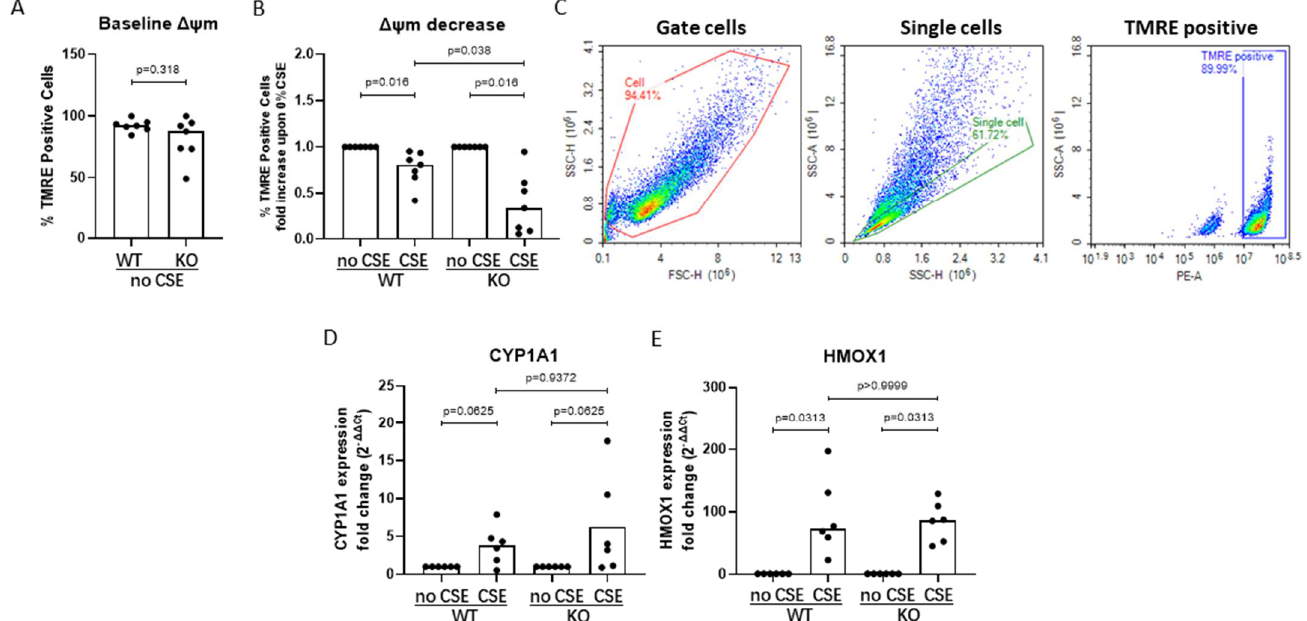
Figure 5. AHRR knockout enhances CSE-induced mitochondrial damage in 16HBE cells. 16HBE wild-type (WT) and AHRR knockout (KO) cells were seeded in duplicate, grown to confluence, serum-deprived overnight and incubated in medium with/without 20% CSE for 4 h before staining with TMRE and mitochondrial membrane potential ( ∆ ψ m) was measured using flow cytometry ( n = 7). For the isolation of RNA, the cells were incubated with medium control or 10% CSE for 6 h before harvesting ( n = 6). Baseline levels of Δψm in 16HBE WT and AHRR KO cells as measured by TMRE assay ( A ). Fold change in Δψm levels upon CSE exposure compared to unexposed cells in WT and AHRR KO, respectively ( B ). Gating strategy of Δψm measurement using flow cytometry of a representative experiment is shown ( C ). As demonstrated in the left panel, live cells were selected based on cell size (forward and side scatter); as indicated in the middle panel, single cells were selected on basis of similar size on the forward and side scatter; as indicated in the right panel, TMRE positive cells were gated (intensity above 10 7 in the PE channel). mRNA levels of CYP1A1 ( D ) and HMOX1 ( E ) were measured using qPCR, related to the expression of housekeeping genes B2M and PPIA and expressed as 2 − Ct . Median levels are indicated. CSE groups were normalized to their medium controls. Differences between WT and AHRR KO were tested with the Mann– Whitney test, and differences between medium and CSE were tested with Wilcoxon rank-sum test. p -values are as indicated between the groups. 3.6. AHRR Knockout Decreases Bronchial Epithelial Cell Viability and Increases Apoptotic Cell Death upon CSE Exposure To assess whether the loss of mitochondrial integrity was accompanied by cytochrome C release and subsequent induction of apoptotic cell death [30], we assessed the effect of AHRR knockout on CSE-induced release of cytochrome C. At the same time, double stranded DNA (dsDNA) [8] was measured as marker of necrotic cell death. At baseline, we did not find differences in both markers between WT and AHRR KO cells (online Supplemental Figure S3). Upon exposure to 20% CSE, we found a significant increase in the levels of cytochrome C, but not dsDNA in both WT and AHRR KO cells, while knockout of AHRR did not significantly alter this effect of CSE (Figure 6A,B). Finally, we assessed whether AHRR knockout affected the induction of different cell death modalities after CSE exposure. In AHRR KO cells we observed a trend towards more live cells and significantly less late apoptotic/necroptotic cells at baseline compared to WT cells (online Supplemental Figure S4). We observed that 20% CSE significantly reduced the percentage of viable cells and significantly increased the percentage of late apoptotic/necroptotic as well as necrotic cells only in AHRR KO cells (Figure 6C–E), while